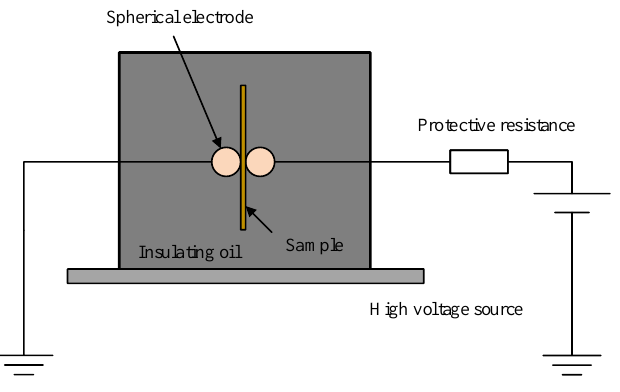
Figure 1. Breakdown field strength test device.